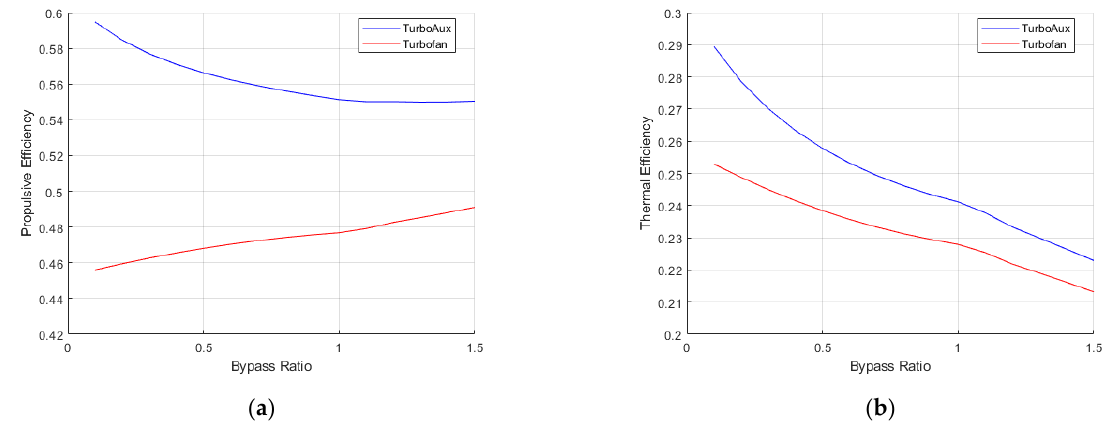
Figure 5. Plots of efficiency vs. bypass ratio ( a ) propulsive and ( b ) thermal efficiency.